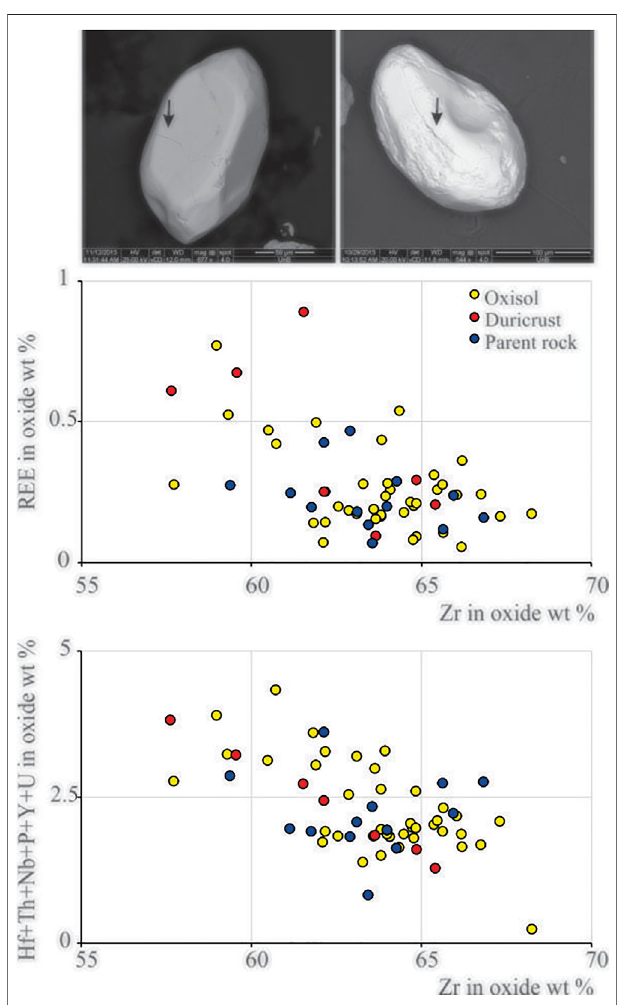
FIGURE 6 | Scanning electron microscope (SEM) images of two zircon grains showing fractures where low-temperature weathering solutions can penetratechangingtheNdsystem.PlotsofREEandSi+Hf+Y+Th+U+Nb + P vs. Zr from EMPA (all elements in oxides concentration and expressed asweight%) ofzircon grains ofpro fi les 1and2onthesedimentary Alter do Chão Formation showing the range between the parent rock and the